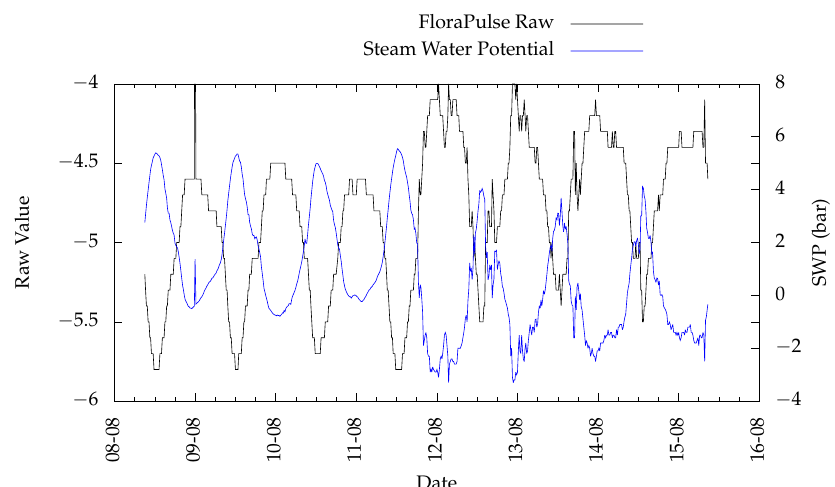
Figure 11. IR data from SIL-411 and Leaf Wetness data from PYTHOS31.